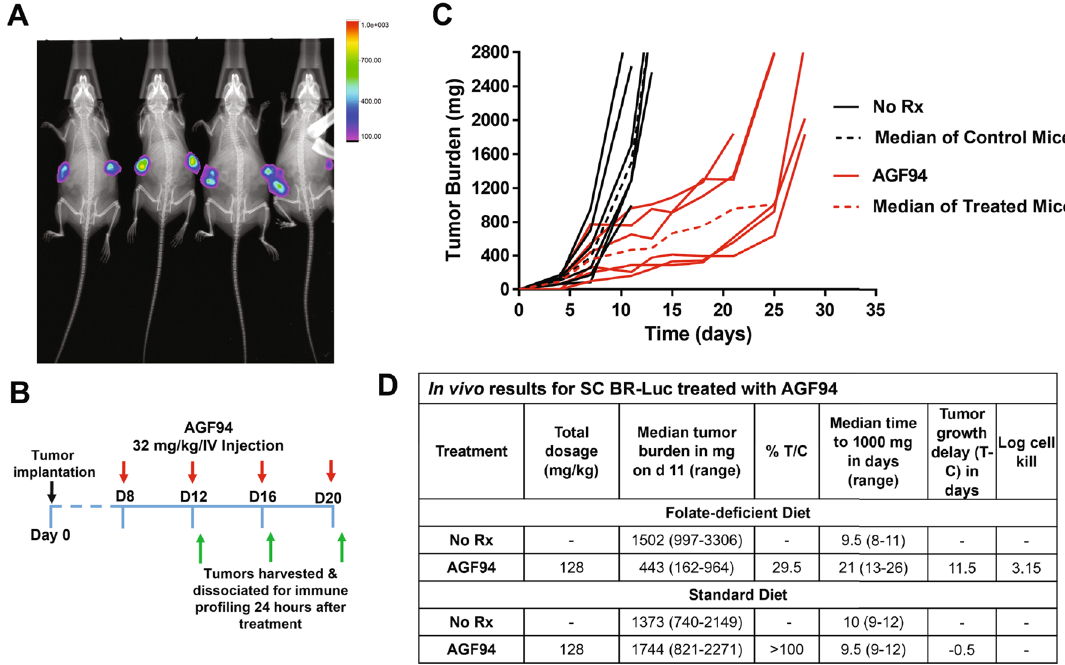
Figure 5. AGF94 efficacy in a subcutaneous BR-Luc model. ( A ) Luminescent images were collected over 3 min and overlayed on top of an X-ray image. The image was obtained 7 days after the tumor was allografted and 1 day prior to treatment initiation. ( B ) The trial design schematic is shown. BR-Luc tumors were engrafted SC bilaterally; treatment with AGF94 began at 8 days when the tumors were palpable (~ 400 mg). Tumors were harvested, dissociated and flow cytometry was performed 24 h after 2, 3, and 4 doses of AGF94 . ( C ) Results are plotted for the BR-Luc trial efficacy arm with AGF94 by individual mice; the median results for 6 mice are shown as broken lines. Female FVB mice were implanted bilaterally SC with BR-Luc tumors and AGF94 treatment was initiated on day 8 following tumor implantation. AGF94 was dosed as Q4dx4 at 32 mg/kg/IV injection. %T/C values were determined on day 11. ( D ) The table summarizes the results of the in vivo trial with SC BR-Luc xenografts treated with AGF94 for mice maintained on both the folate-deficient and standard folate replete